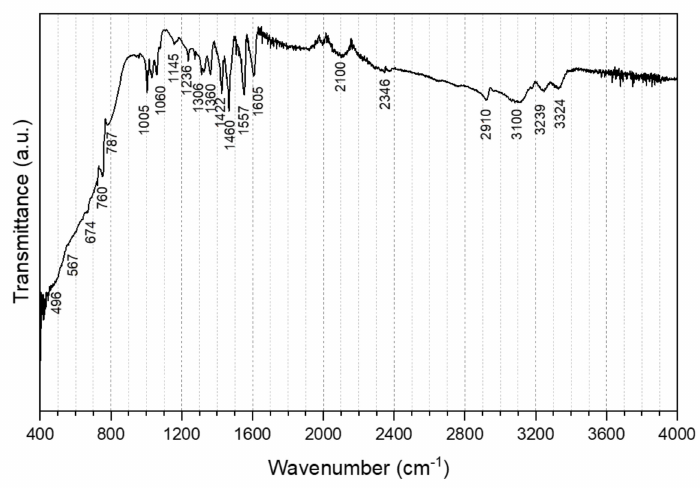
Figure 3. FT-IR spectrum of Ce x Ti y O z nanocontainers loaded with